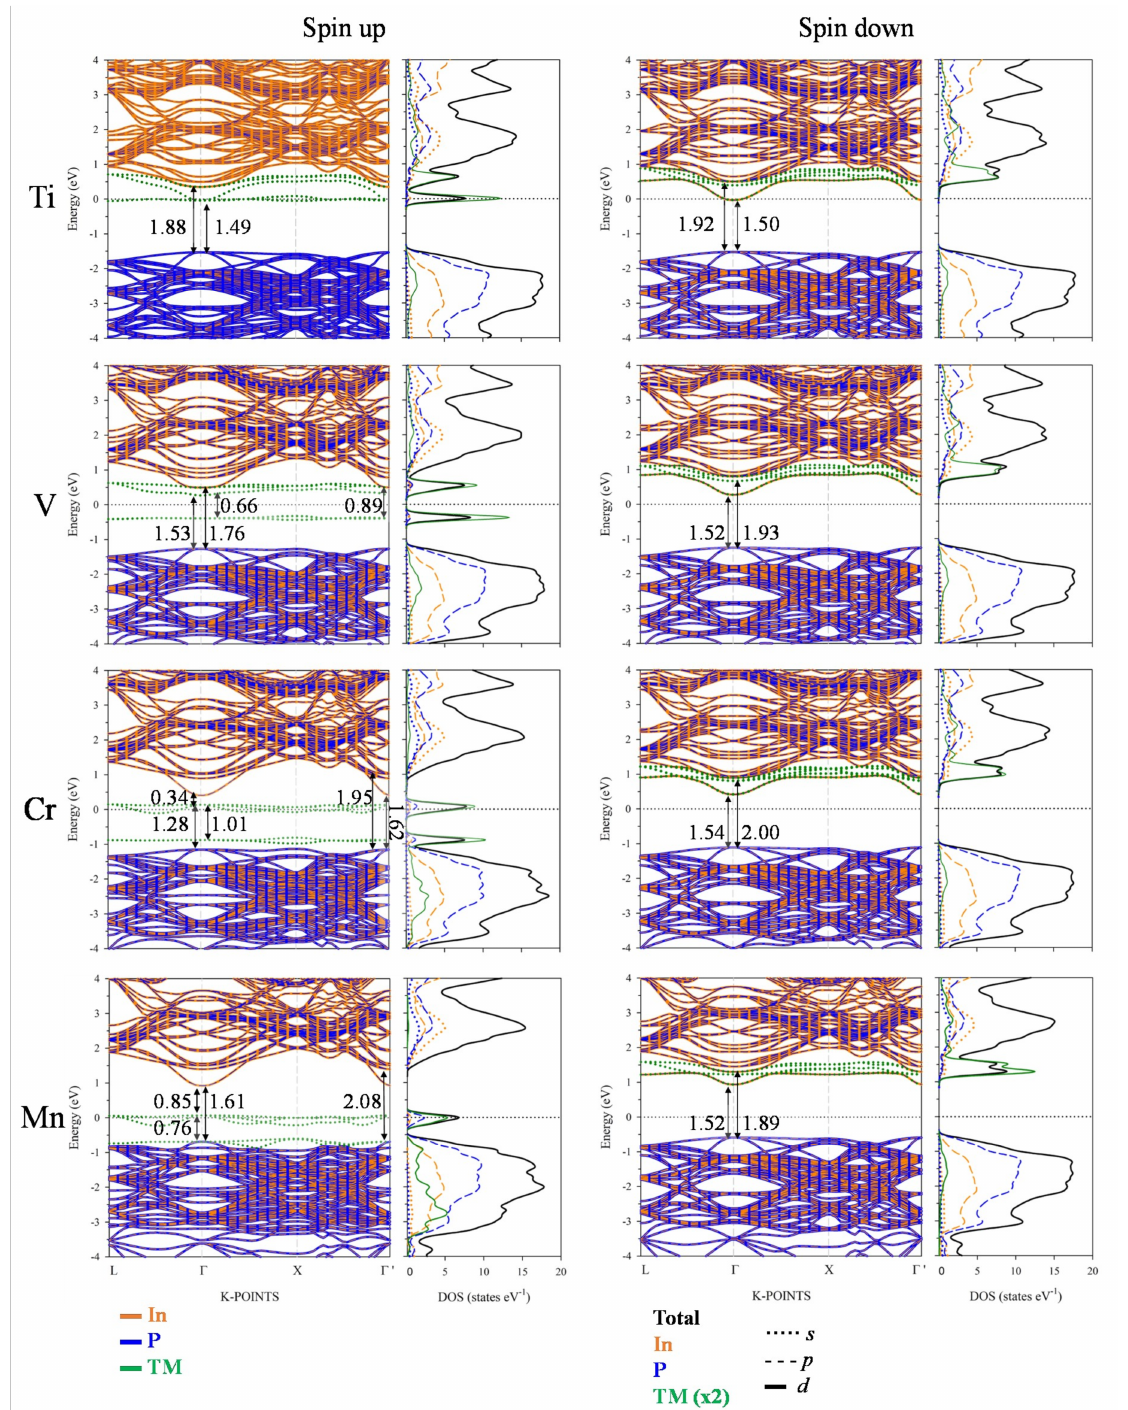
Figure 5. Projected electronic band structure (only the main atomic contribution was considered) and density of states of TM@InP calculated within PBE + U ( U e ff = 15 eV) approach, along with main energy di ff erences at Γ -point. The zero energy was set at the Fermi level (black dotted